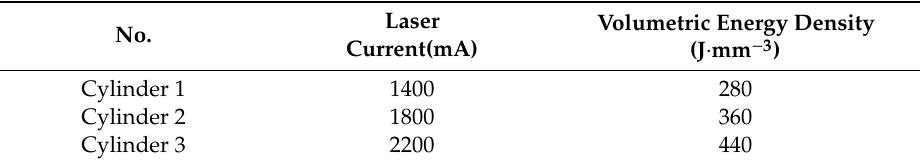
Table 2. Laser current and volumetric energy density applied to produce TiB 2 -Si solid parts.